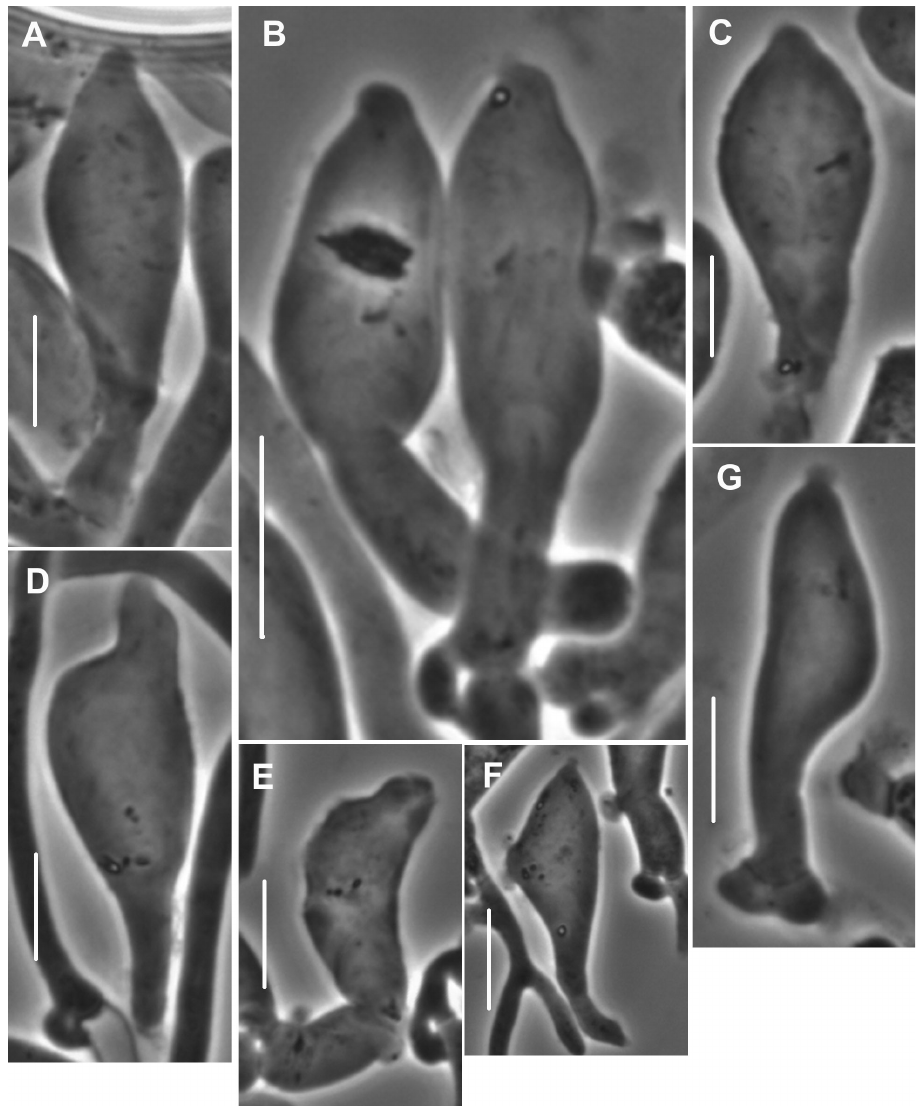
Figure 47. Mycetinis olidus . Cheilocystidia. Standard bars = 10 µm. MG 1973 (MICH-F-0051239). querceus ) is accepted in Mycetinis , but for an apparent European taxon, basidiomata